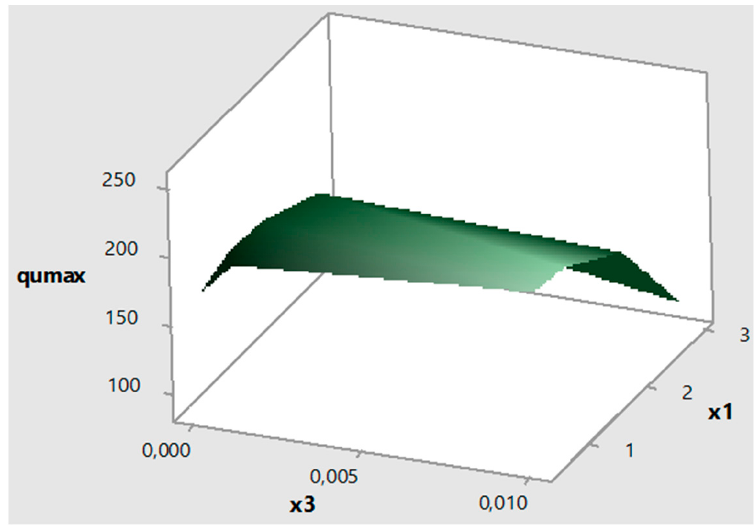
Figure 5. Surface plot of q u max vs. x1 and x3.